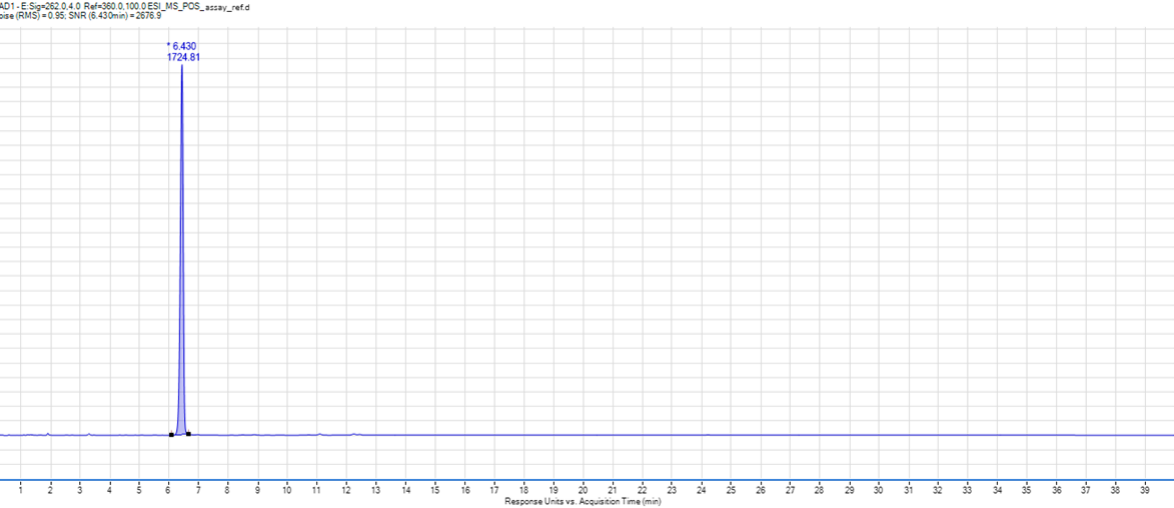
Fig. 3. The chromatogram of comparison solution